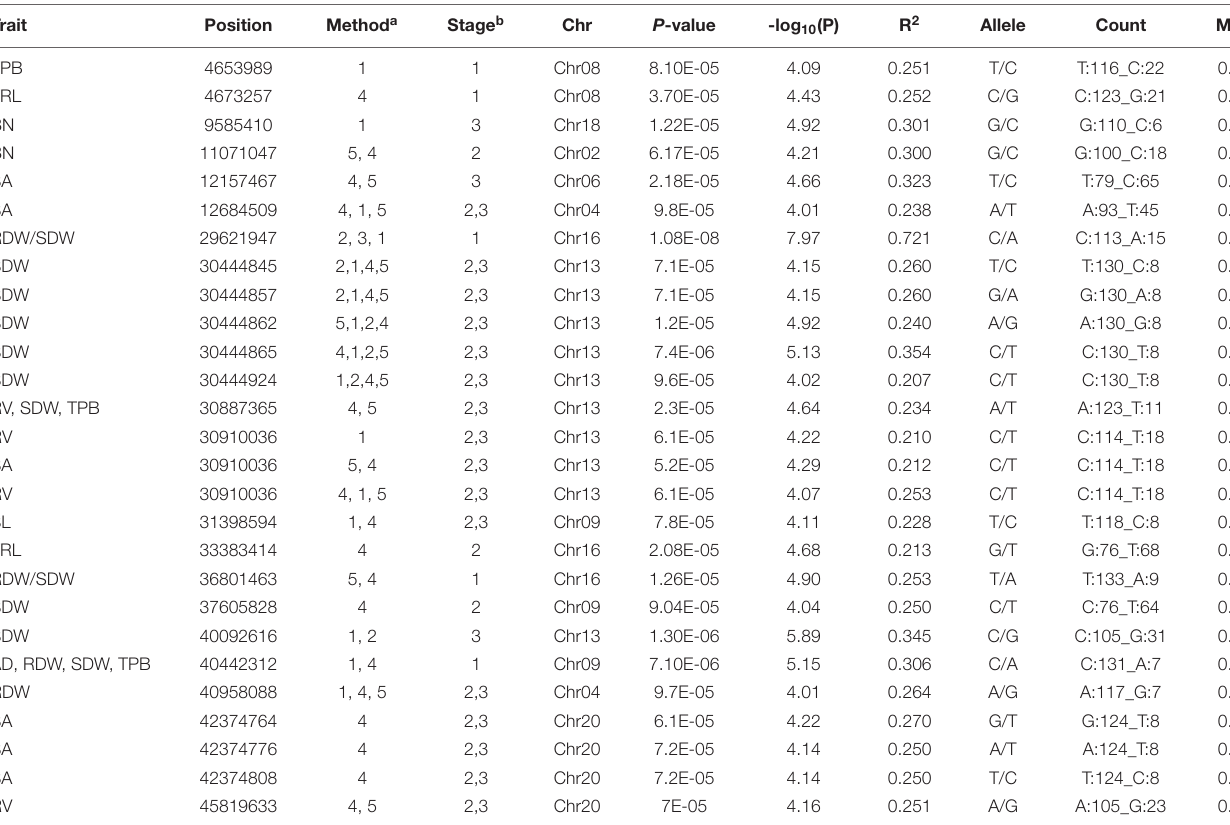
TABLE 4 | Significant SNPs associated with root and shoot related traits detected by GWAS.